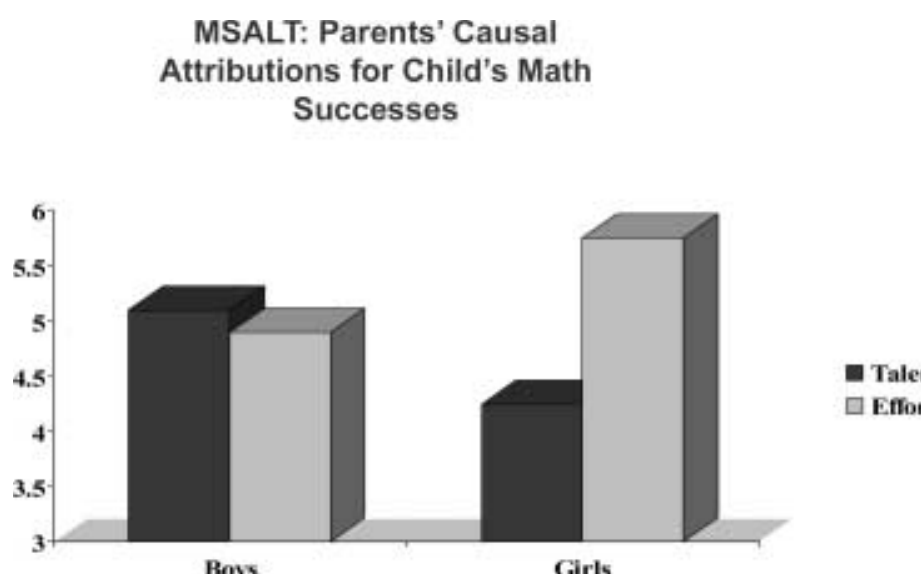
Figure 5. Parents’ causal attributions for child’s math